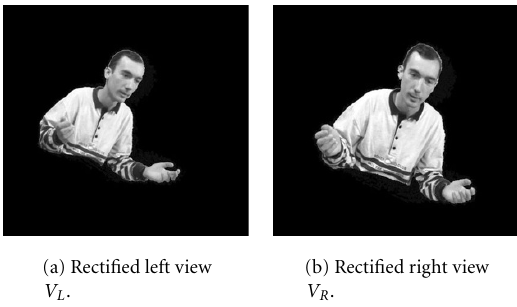
Figure 6: The stereo views are rectified without considering the epipolar geometry. To retain all the information (including the black area) from the original views, they may have di ff erent sizes. In this stereo setup, the size of the rectified left view is 1012 × 955 and that of the rectified right view is 848 × 811.